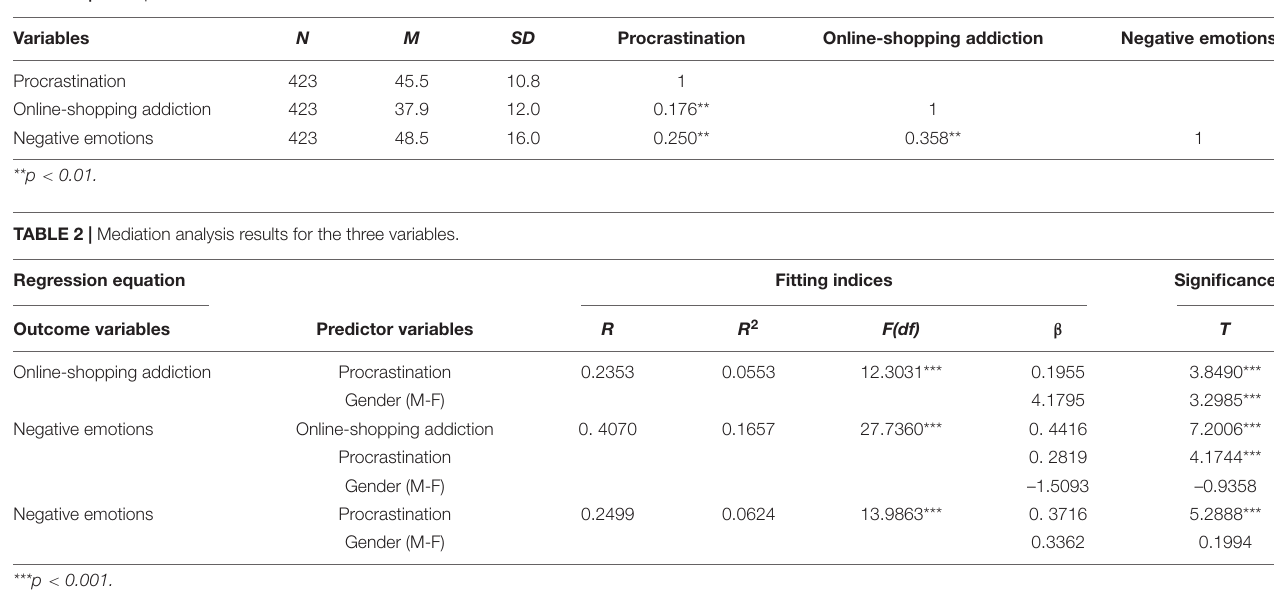
TABLE 1 | Descriptive statistics and Pearson’s r for the variables.